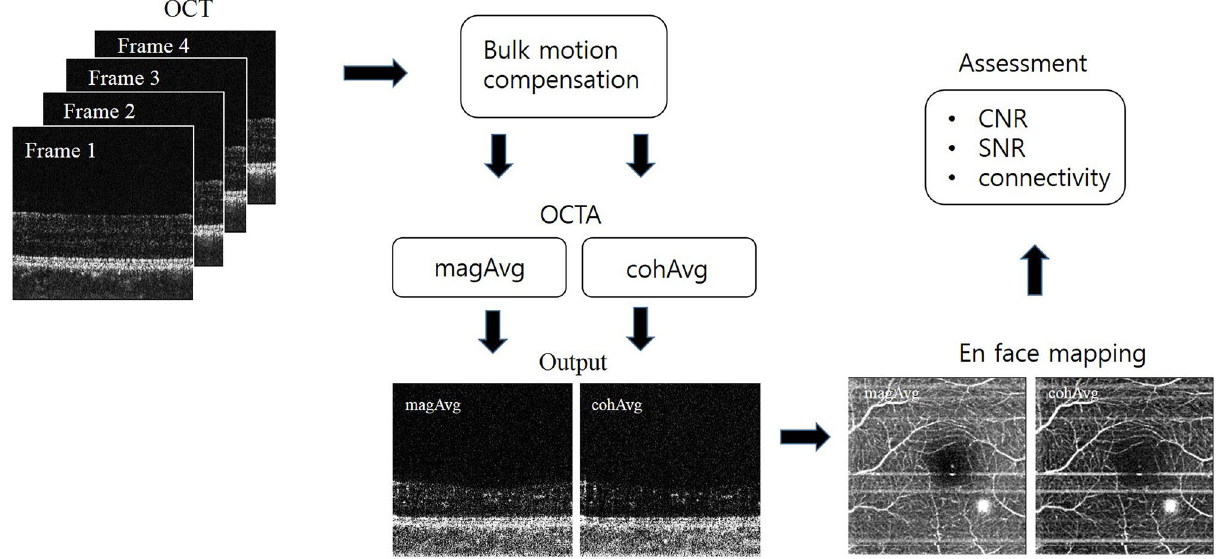
Figure 7. OCTA image acquisition procedure showing the differences between magAvg and